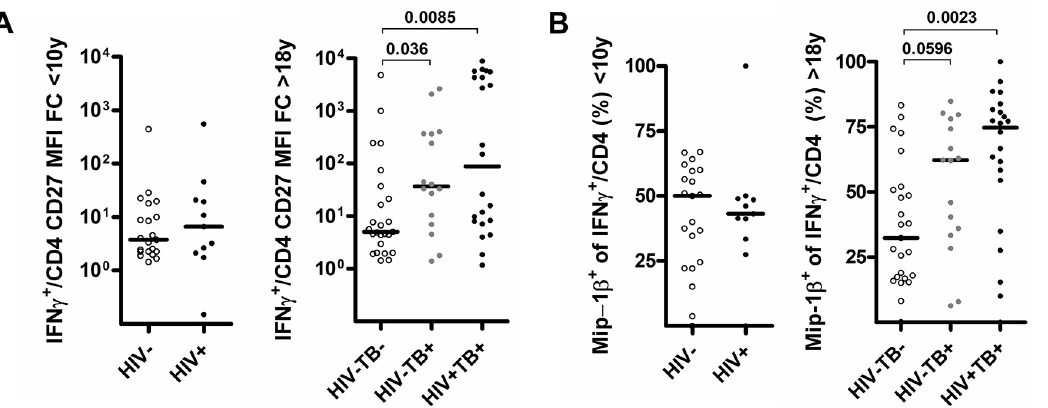
Fig 5. CD27 and Mip-1 β expression of CMV specific IFN γ producing CD4 T cell responses are influenced by HIV as well as tuberculosis co- infection in adults. Scatter-plots illustrating (A) the CD27 MFI fold-change to all CD4 + T cells and B) the proportion of cells producing Mip-1 β of CMV specific IFN γ + -CD4 + T cell in patients under 10 or over 18 years old and according to HIV and TB infection status.